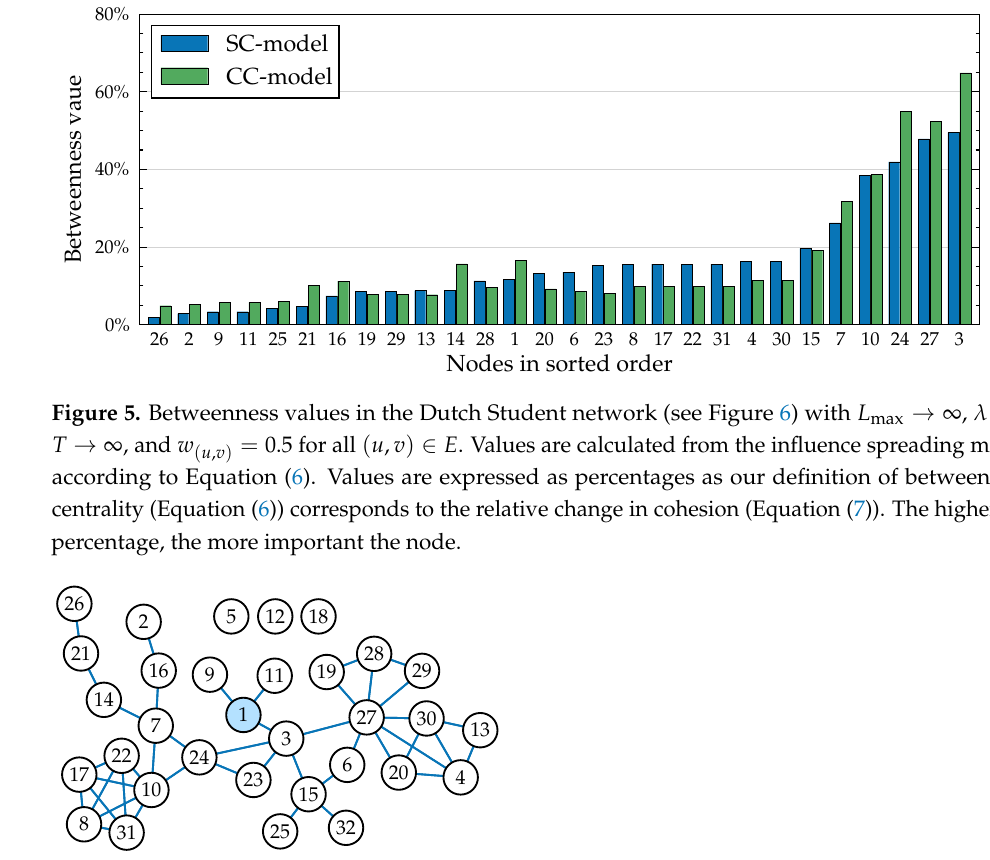
Figure 6. The depicted network was constructed based on data collected by Van de Bunt [26]. It is a longitudinal friendship network among 32 Dutch students. Its small size and unique structure make it a great example network for our centrality and betweenness measures. Note that there are three unconnected nodes numbered 5, 12, and 18. They were left out of Figures 3–5 as they do not provide any significant